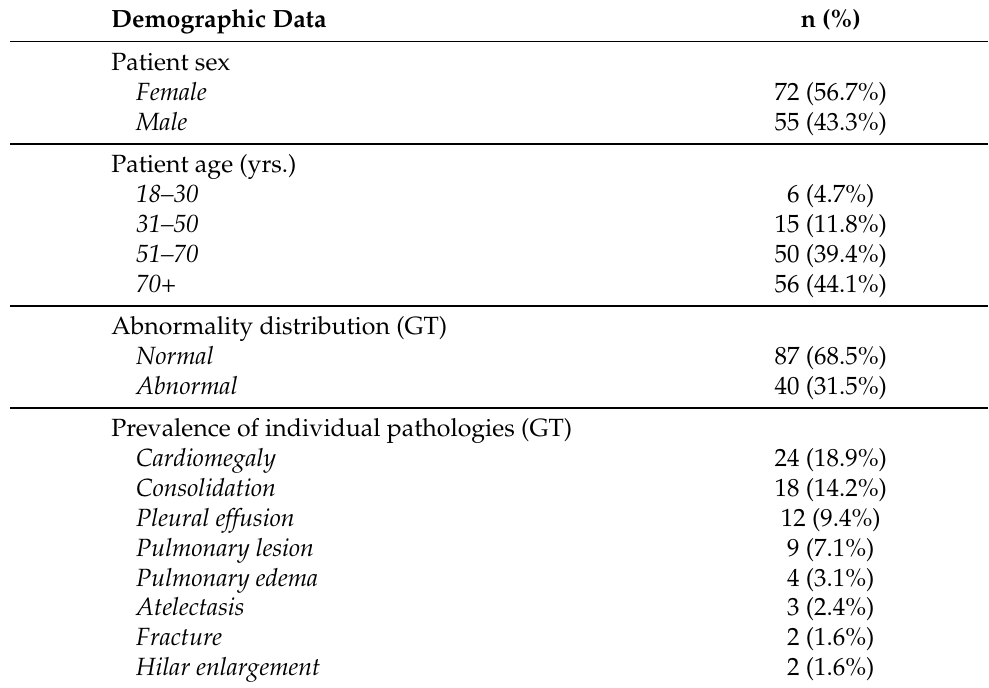
Table 2. Patient demographic data and findings